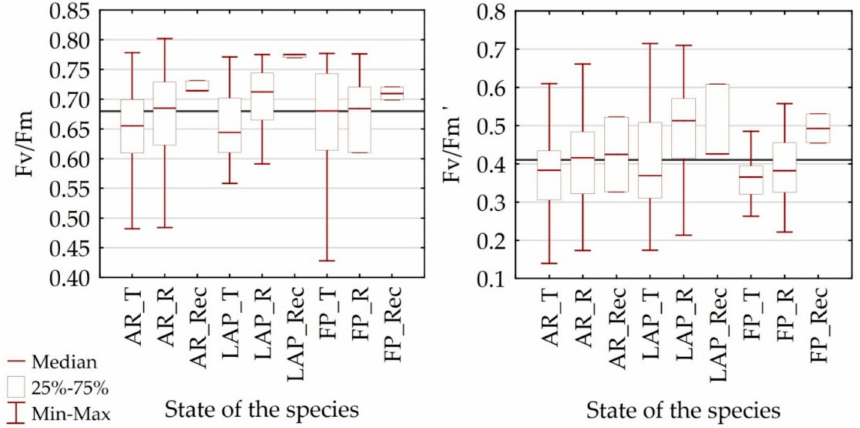
Figure 10. Values of fluorescence indices: Fv / Fm (with an adaptation to a darkness) and Fv / Fm‘ (without an adaptation to a darkness), n = 49,375 per species. Explanation: AR_T – Agrostis